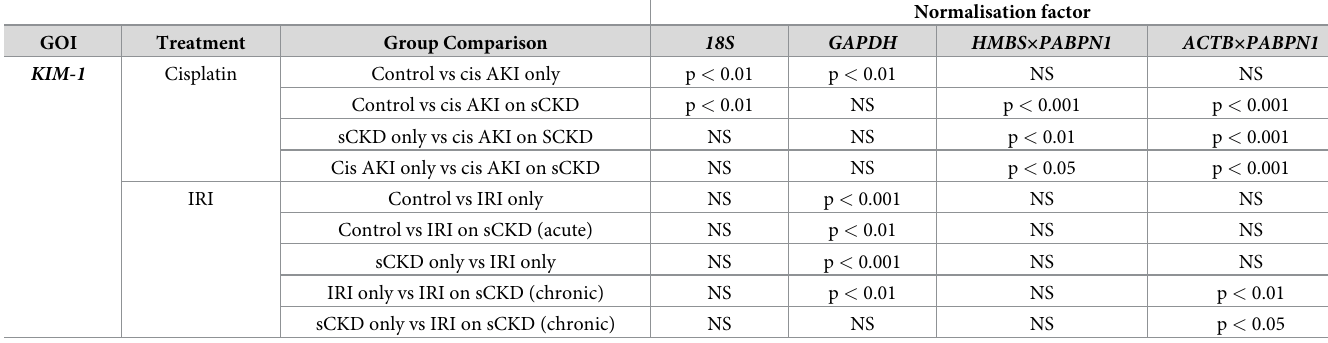
Table 8. Statistical differences of KIM-1 normalised to different reference genes and reference gene combinations.